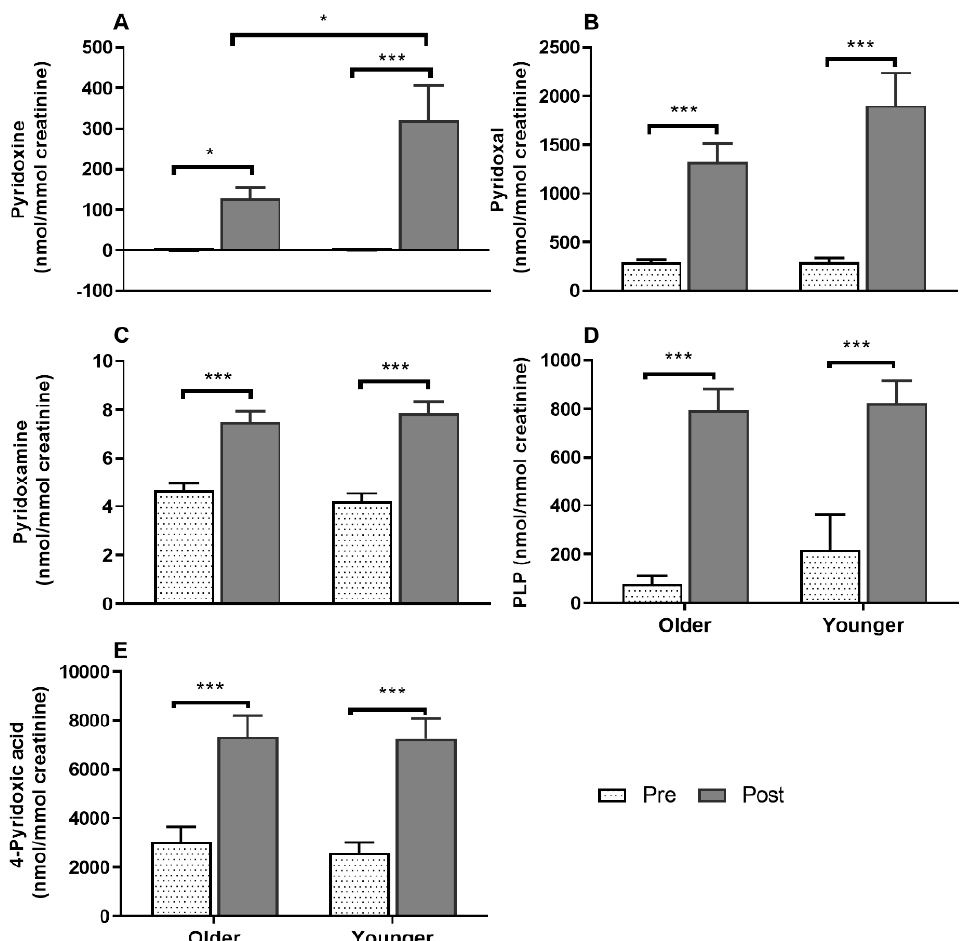
Figure 4. Urinary concentrations of the vitamers of vitamin B 6 , ( A ), pyridoxine ( B ), pyridoxal ( C ), pyridoxamine ( D ) pyridoxal 5 ′‐ phosphate (PLP), and ( E ) 4 ‐ pyridoxic acid at baseline (pre) and after (post) supplement ingestion in older and younger adults. Bar plots and error bars represent means and ± SEM, respectively, n = 20 in each age groups and concentrations are normalized for urinary creatinine (nmol/mmol creatinine). Data for pre and post supplement ingestion was compared using generalized linear repeated measures analysis of variance with time as within subject and age as between subject factor. Sidak post hoc test was applied for pairwise comparisons in case of an interaction. All the urinary vitamers increased following supplement ingestion compared to baseline (main time effect, *, p < 0.05; *** p < 0.001). A time x age interaction ( p = 0.037) showed a greater urinary concentration of pyridoxine in younger compared to older adults post ‐ supplement ingestion. There were no significant differences in urinary excretion of other vitamers between older and younger adults.